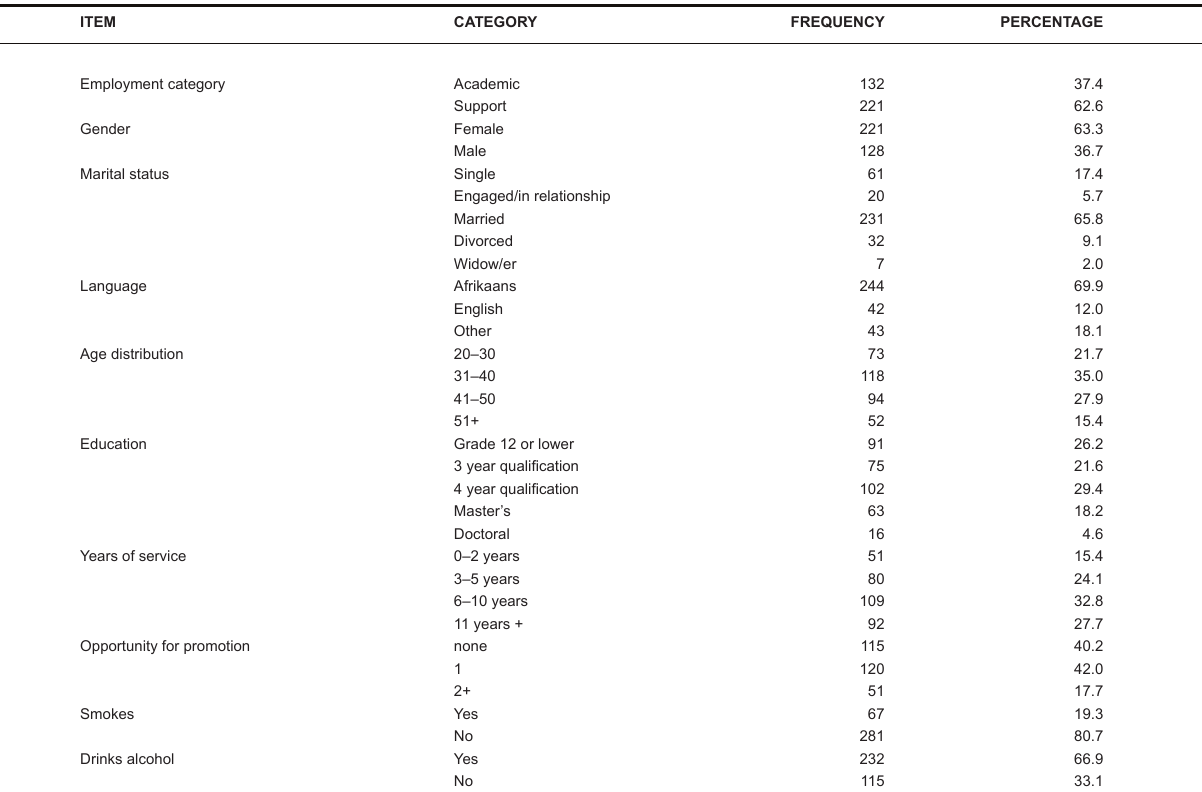
taBLe 1 Characteristics of